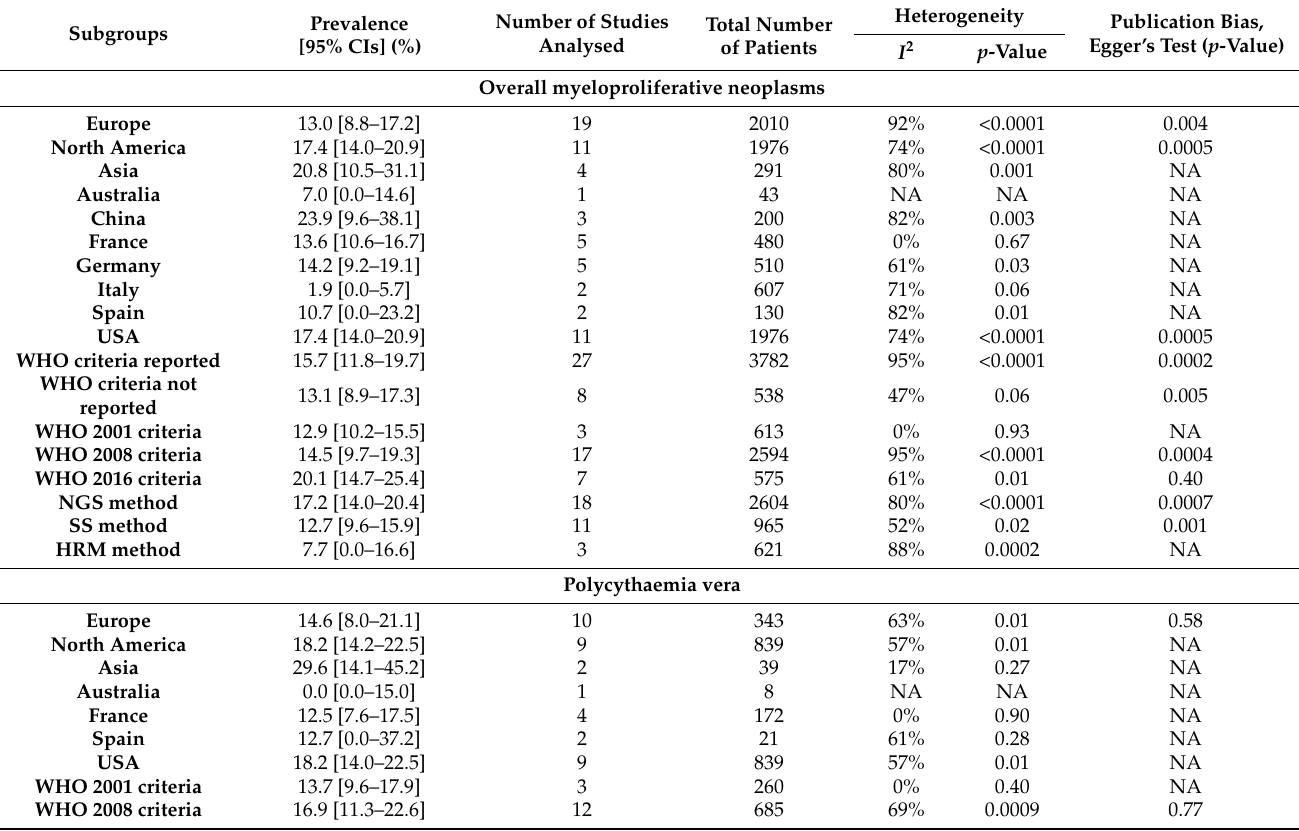
Table 2. The pooled prevalence of TET2 gene mutations in different subgroups of